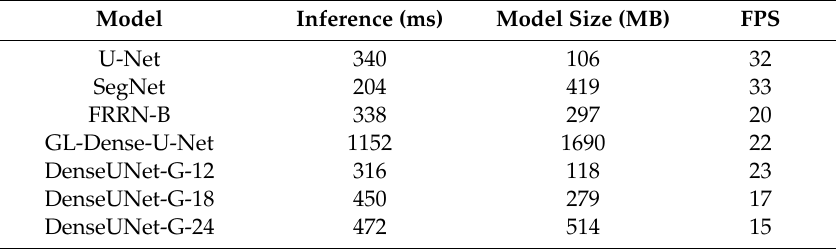
Table 5. Compare the network e ffi ciency between the tested deep learning model and